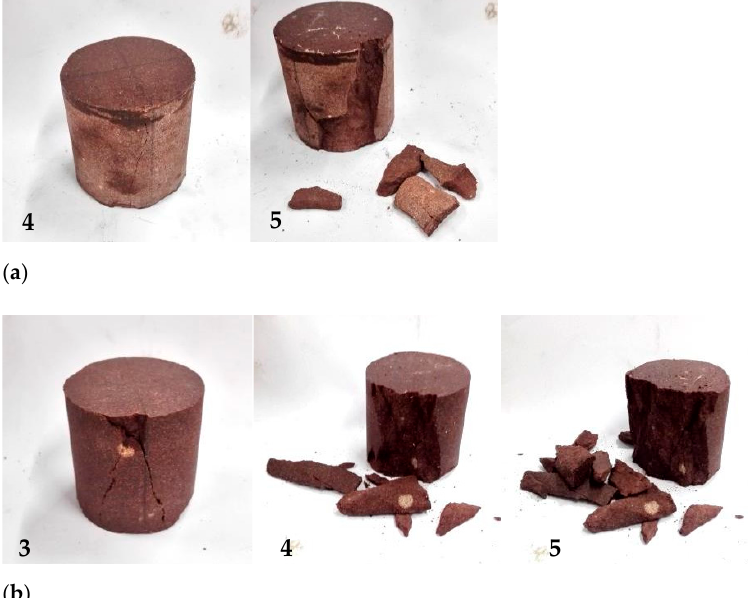
Figure 8. Failure form of rock samples. ( a ) Semisaturated sample. ( b ) Saturated samples.